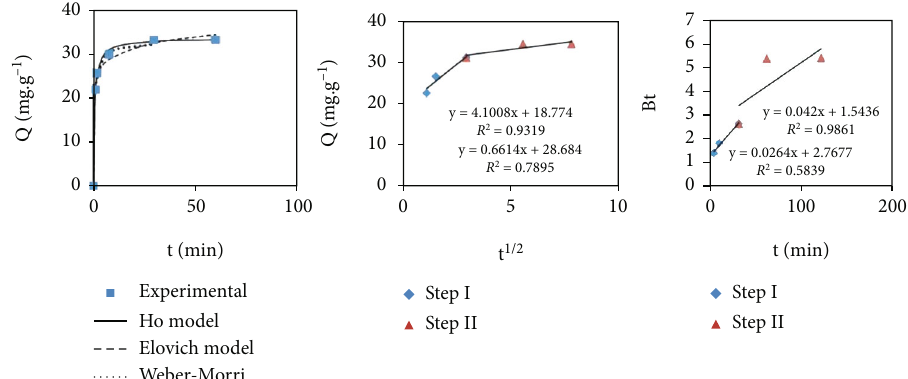
Figure 11: Experimental curves and the Ho, Elovich, and Webber-Morri models of the kinetic study of Pb(II) ion adsorption in sodic clay.